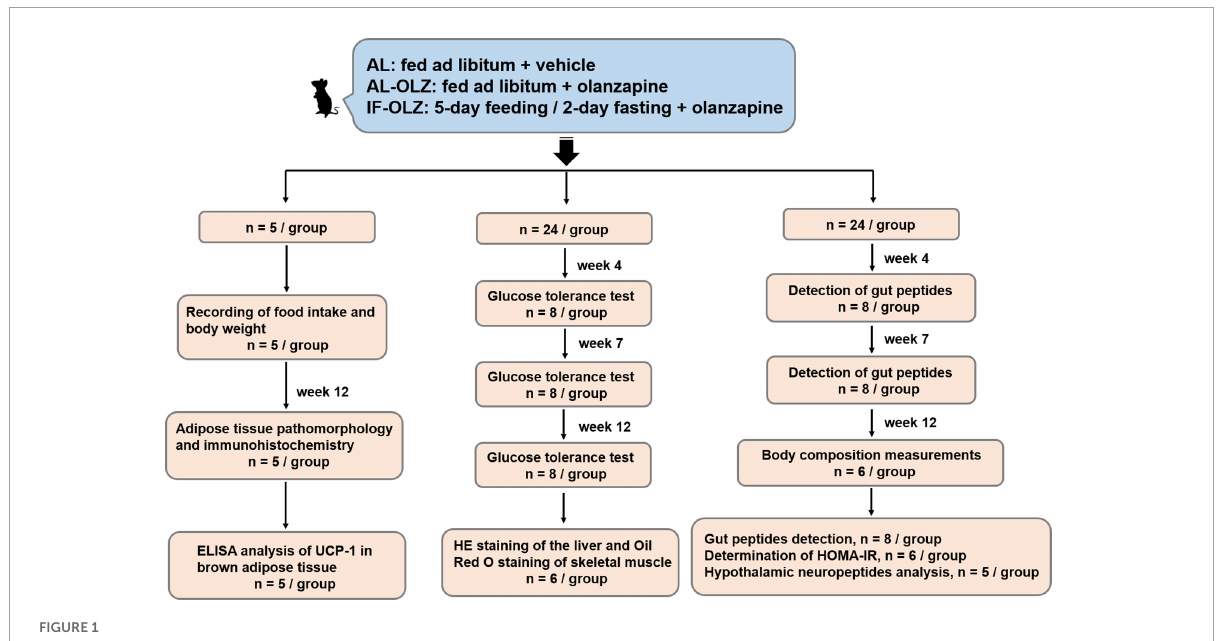
FIGURE1 Flow diagram of study